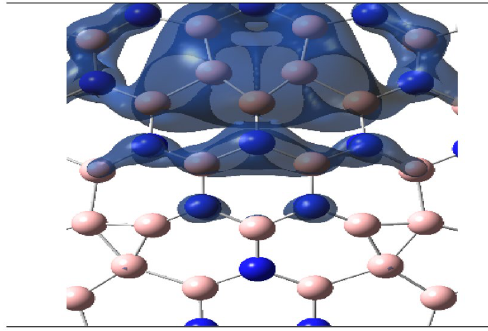
Fig. 5 Atomic charges of a BN nanosheet pristine, b B nanosheet, and c B nanosheet. In red and deep red: negative; green: